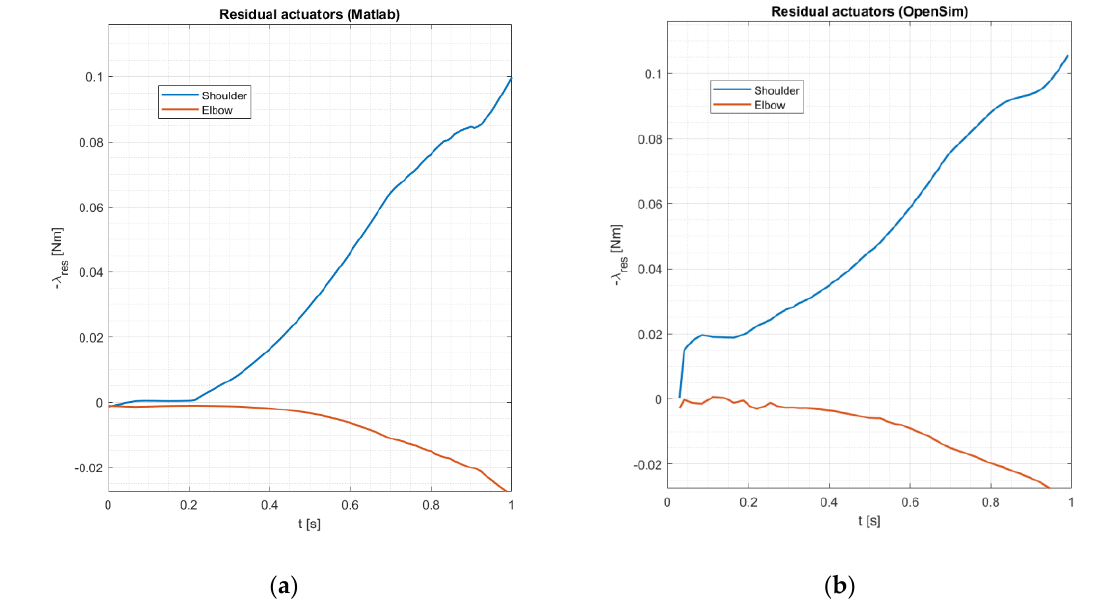
Figure 19. Residual actuators: ( a ) Matlab and ( b ) OpenSim.